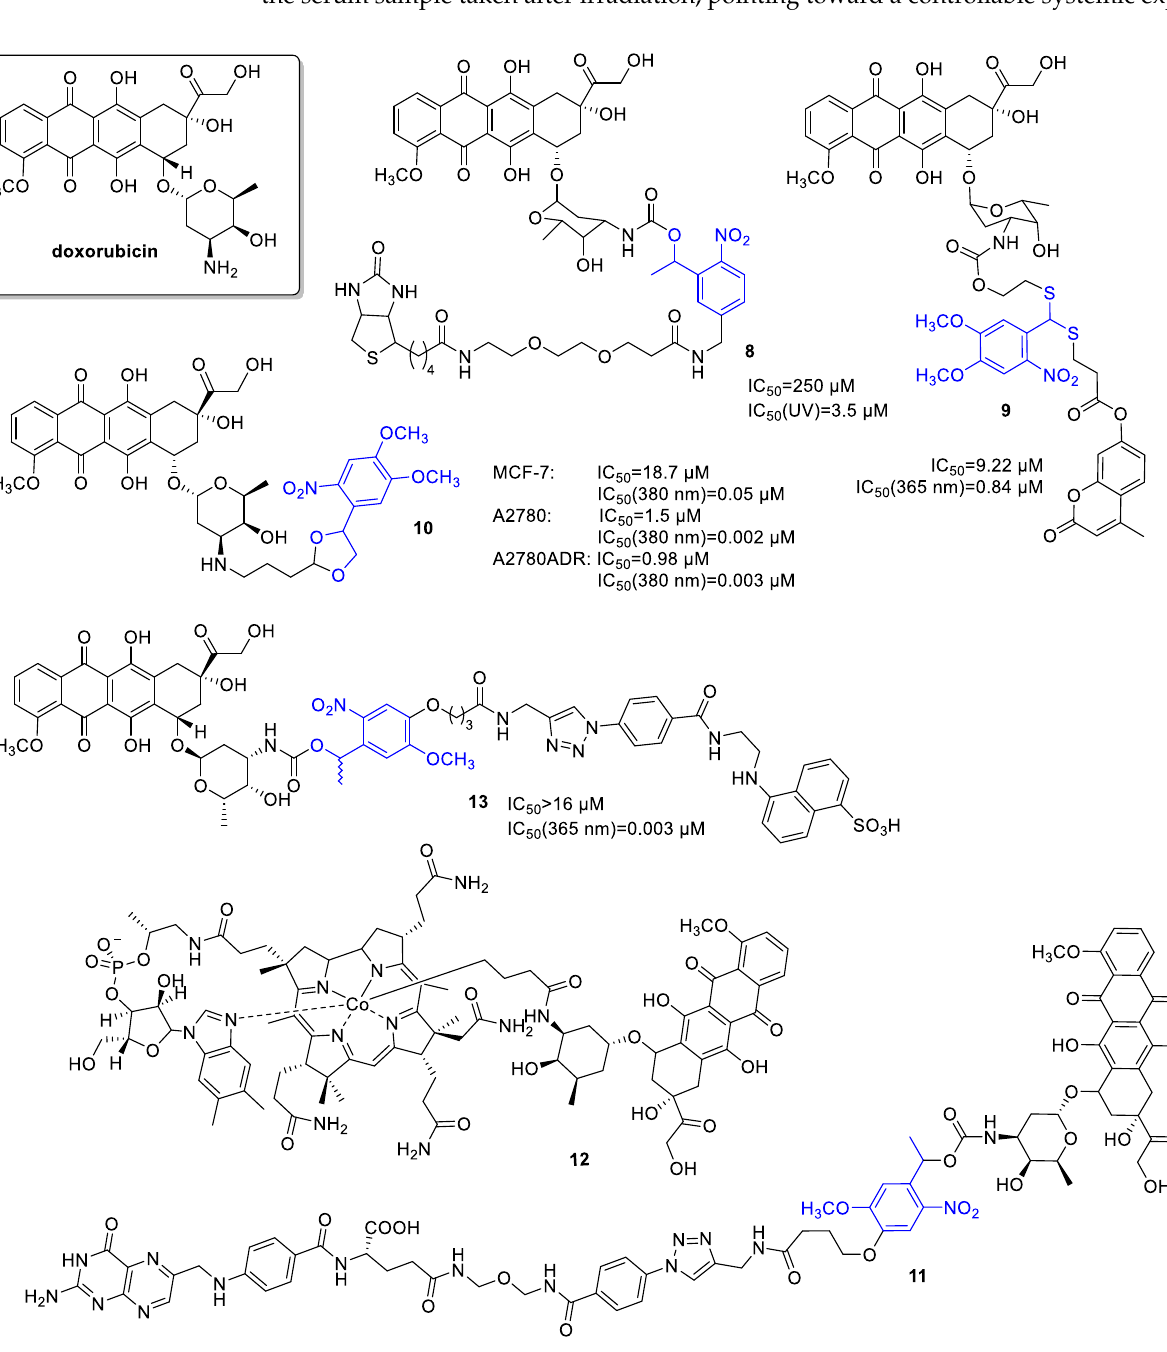
the unirradiated tumors vs. an increased doxorubicin content at the irradiation site (~6-fold difference in doxorubicin /gram of tumor tissue between irradiated and unirradiated tu- mors). The former was ascribed to the effect of UV leakage. No doxorubicin was detected in the serum sample taken after irradiation, pointing toward a controllable systemic exposure.